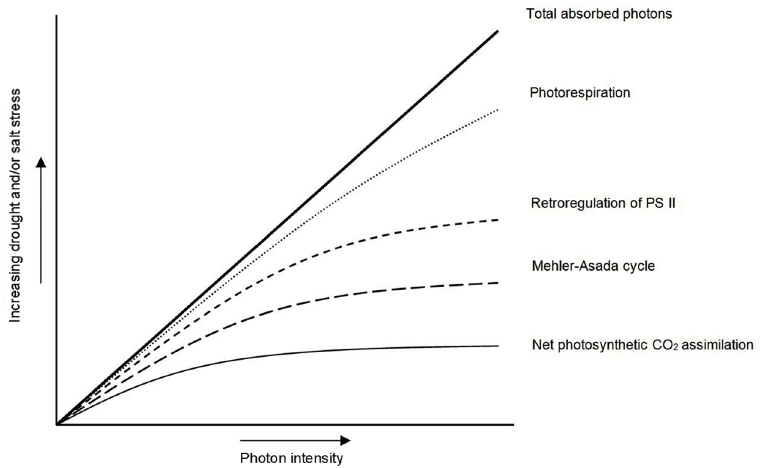
Figure 1. Changes in the destination of absorbed photons with increasing degrees of drought or salinity has effects on some plant physiological and biochemical